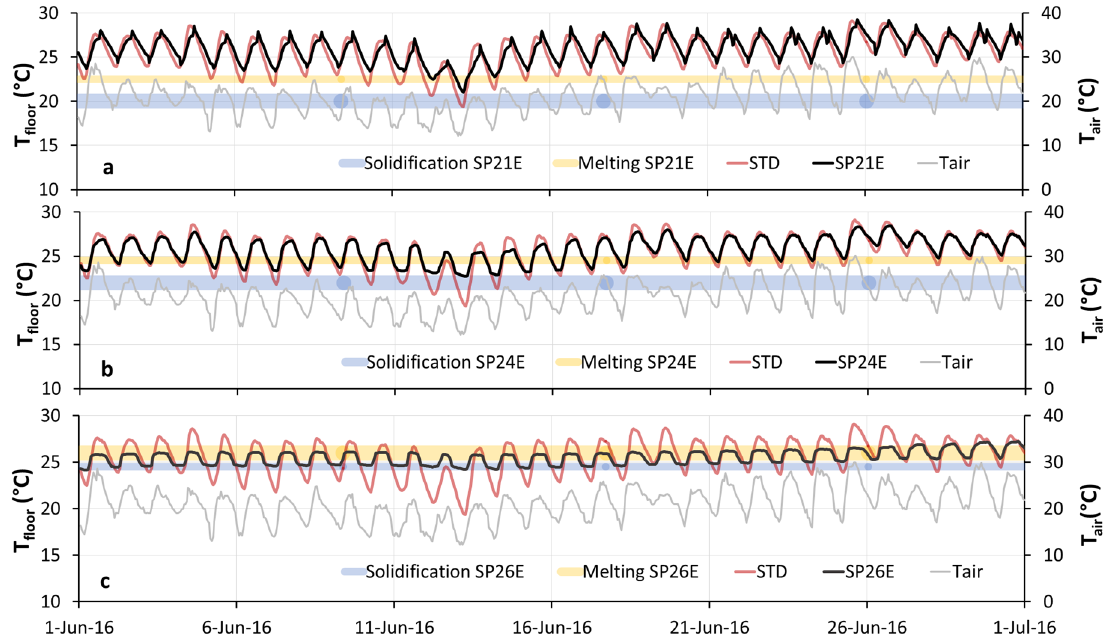
Figure 10. Floor temperatures compared to melting and solidification temperature range of PCM for the month of June in Rome: ( a ) SP21E; ( b ) SP24E; ( c ) SP26E.